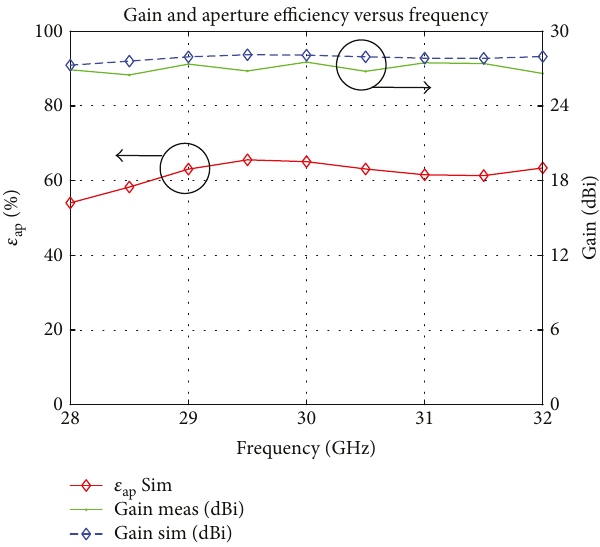
Figure 10: Simulated and measured gain versus frequency from the proposed re fl